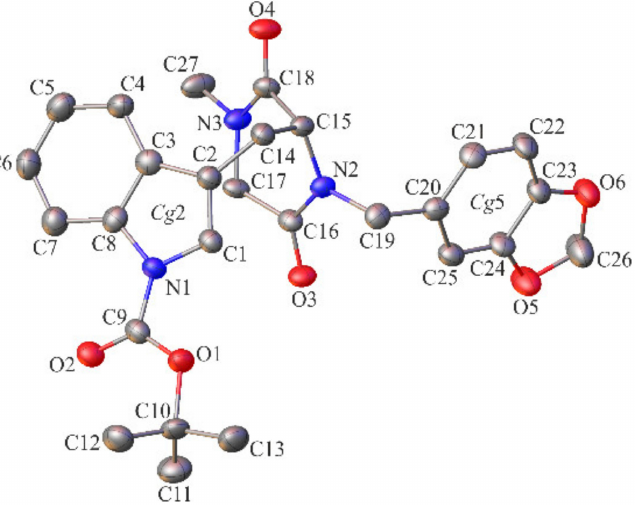
Figure 4. Asymmetric unit of the crystal lattice of 12a with crystallographic numbering. Displacement ellipsoids are drawn at the 50% probability level and the H-atoms were omitted for clarity. Cg 2 and Cg 5 denote the geometric centres of gravity of the aromatic rings delineated by the N1/C1–C3/C8 and C20–C25 atoms,